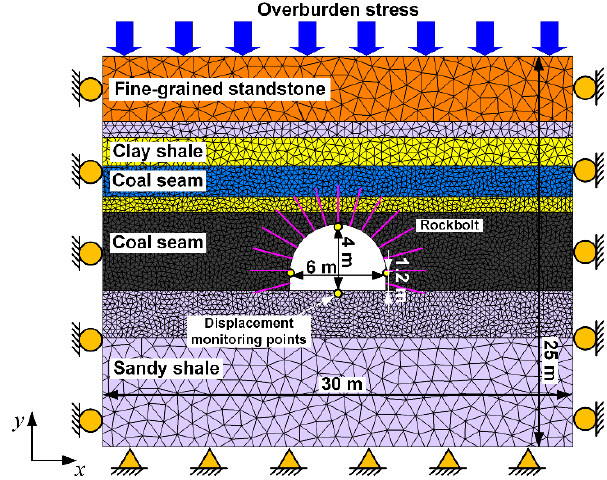
Figure 4. 2D numerical model of a deep tunnel in an underground coal mine. The rock masses are divided into triangular blocks using the Trigon approach [38].